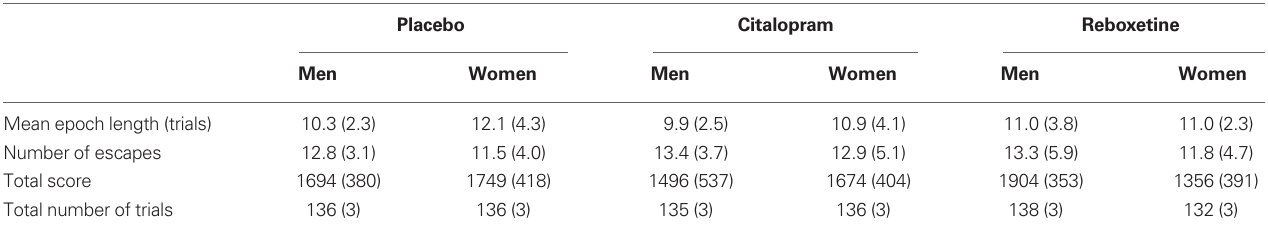
Table 2 | Overview of the dependent variables in the diminishing-utility task, as a function of treatment and sex (SD in parentheses). Placebo